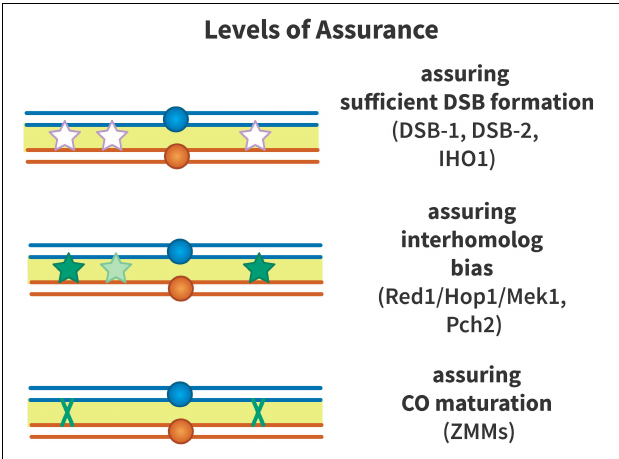
FIGURE 4 | Levels of crossover assurance. Assurance is enforced at three levels. DSB-1 and DSB-2 form a checkpoint in C. elegans that ensures that sufficient double-strand breaks (DSBs, white stars) are formed to generate an obligate crossover. In mouse, IHO1 plays a similar role. From this pool of DSBs, inter-homolog recombination is promoted by Red1, Hop1, Mek1, and Pch2 to ensure that recombination intermediates (light green stars) engage with the homologous chromosome to form crossover precursors (dark green stars). The driving force to generate crossover precursors may be aggregation of ZMM proteins at recombination nodules or mechanical stress that must be relieved by crossover formation. Efficient crossover maturation (dark green X) is ensured by the ZMM proteins that define the class I crossover